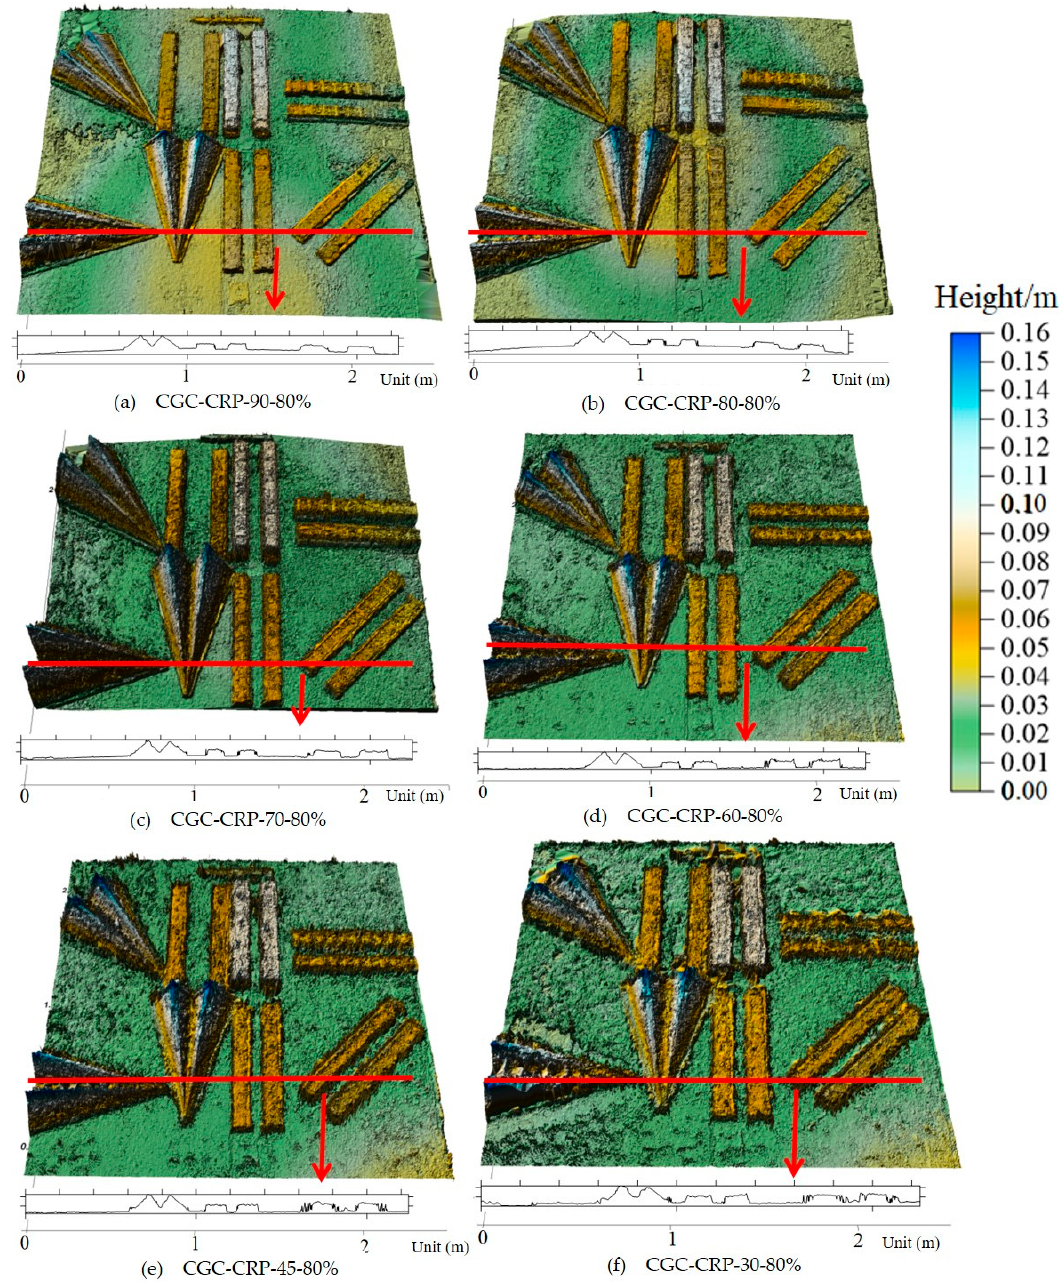
Figure 5. Maps generated from DEMs obtained using the CGC-CRP method with different camera shooting angle settings, ( a ) 90°, ( b ) 80°, ( c ) 70°, ( d ) 60°, ( e ) 45°, and ( f ) 30°, with an overlapping rate of 80%. An example transect extracted from each DEM was shown at the bottom of the map.